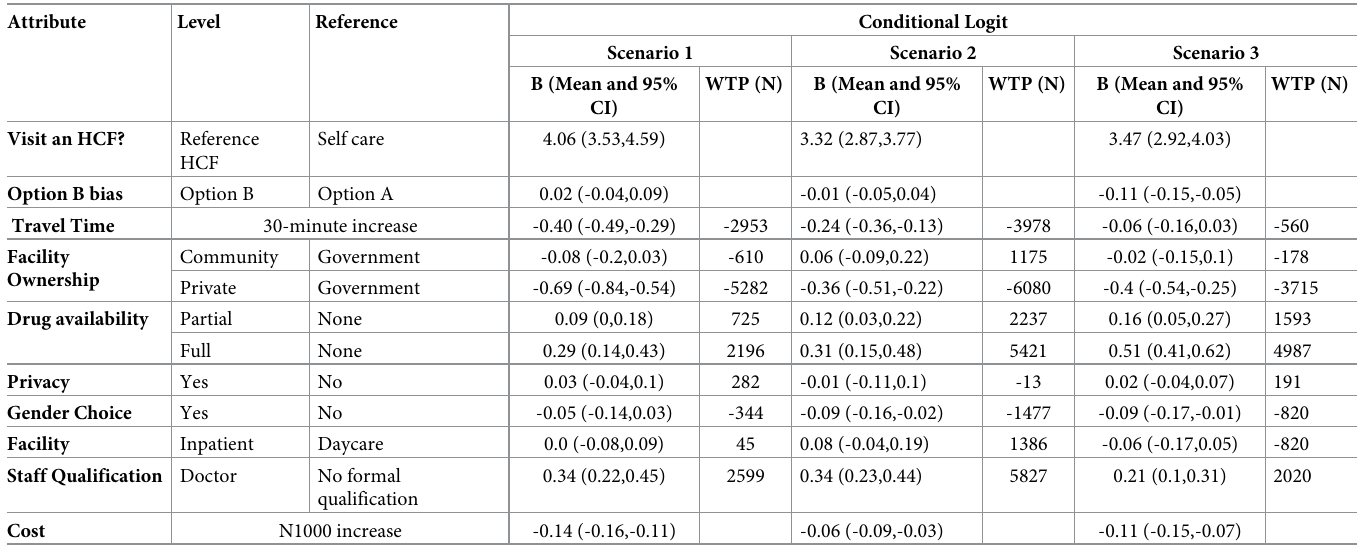
Table 4. Conditional logit model results for each